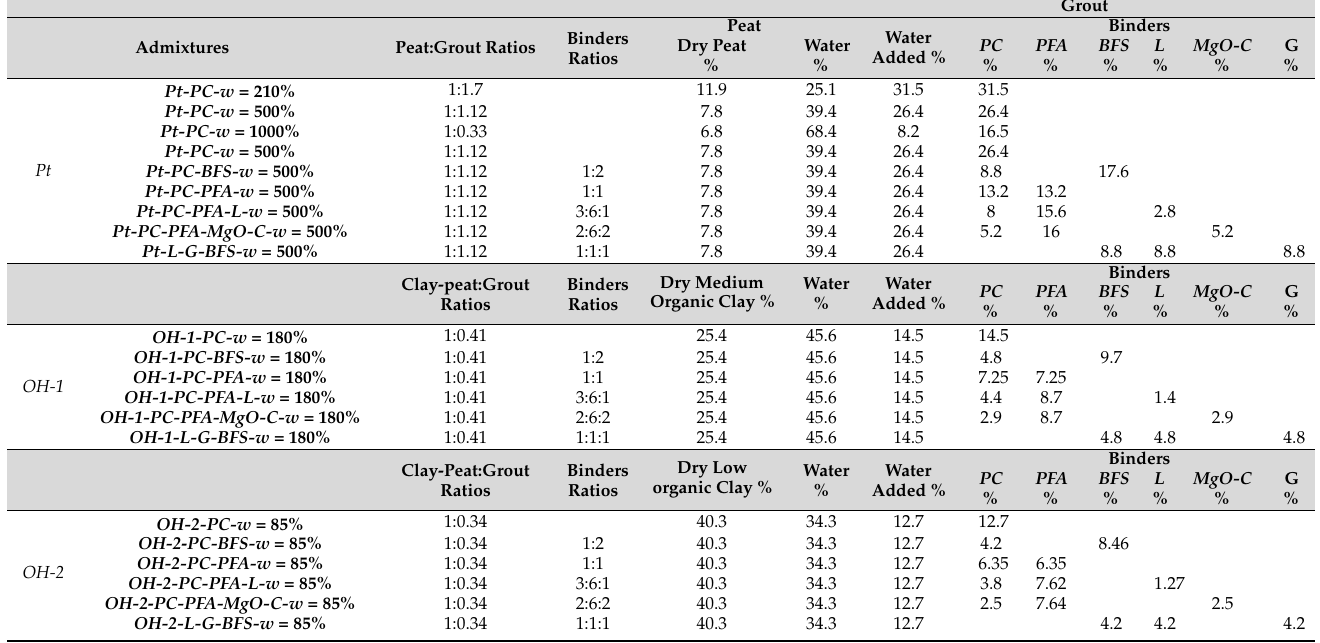
Table 2. Binder mixtures characteristics (%